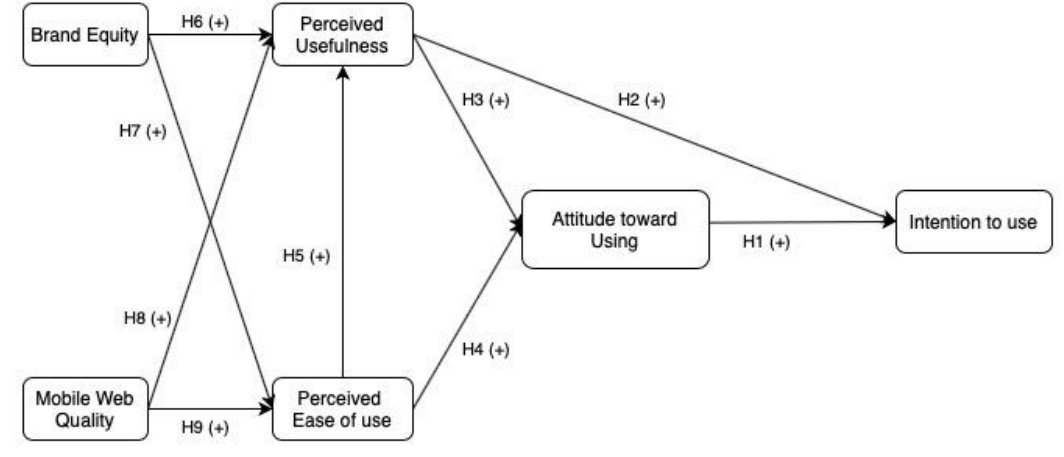
Figure 1: Conceptual Framework of